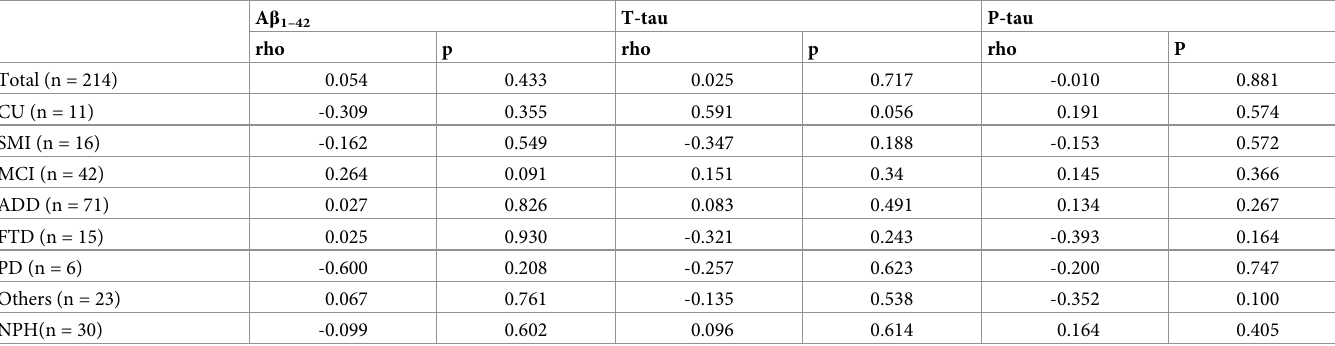
Table 2. Association between serum PGRN and CSF